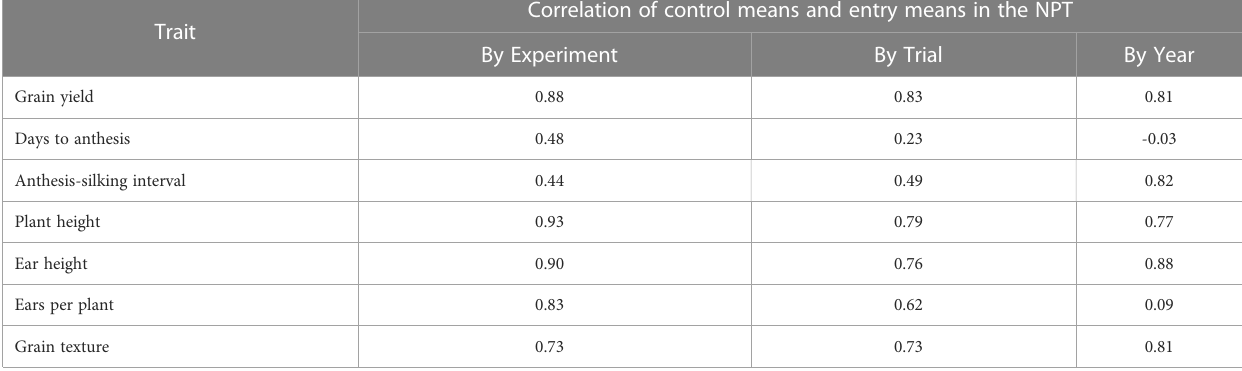
TABLE 5 Correlation of entry means with control (check) means by NPT experiment, trial, and year. Correlation of control means and entry means in the NPT Trait